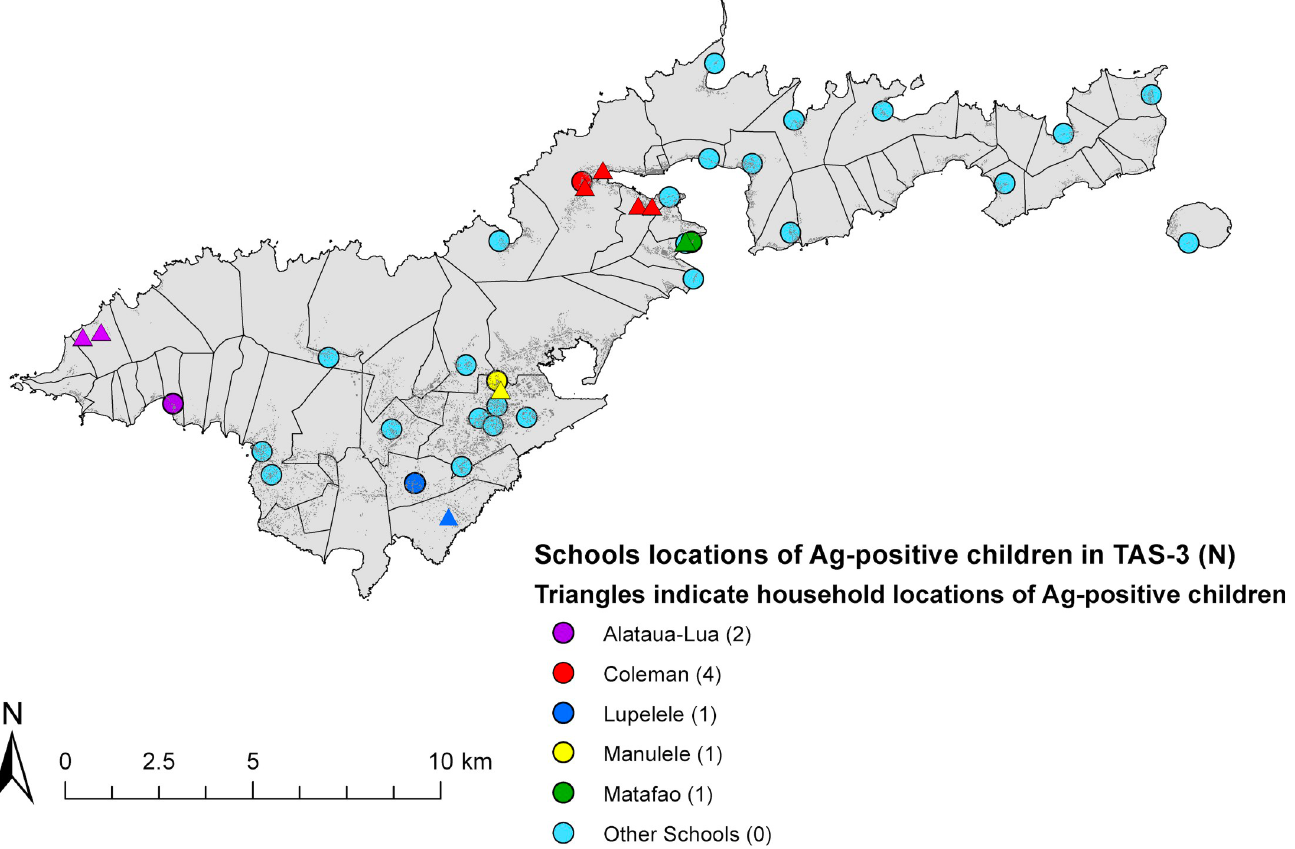
Fig 4. Locations of schools (circles) and households (triangles) of Ag-positive children identified in TAS-3 (index children), American Samoa 2016. Colours of triangles indicate the school location of each index child.